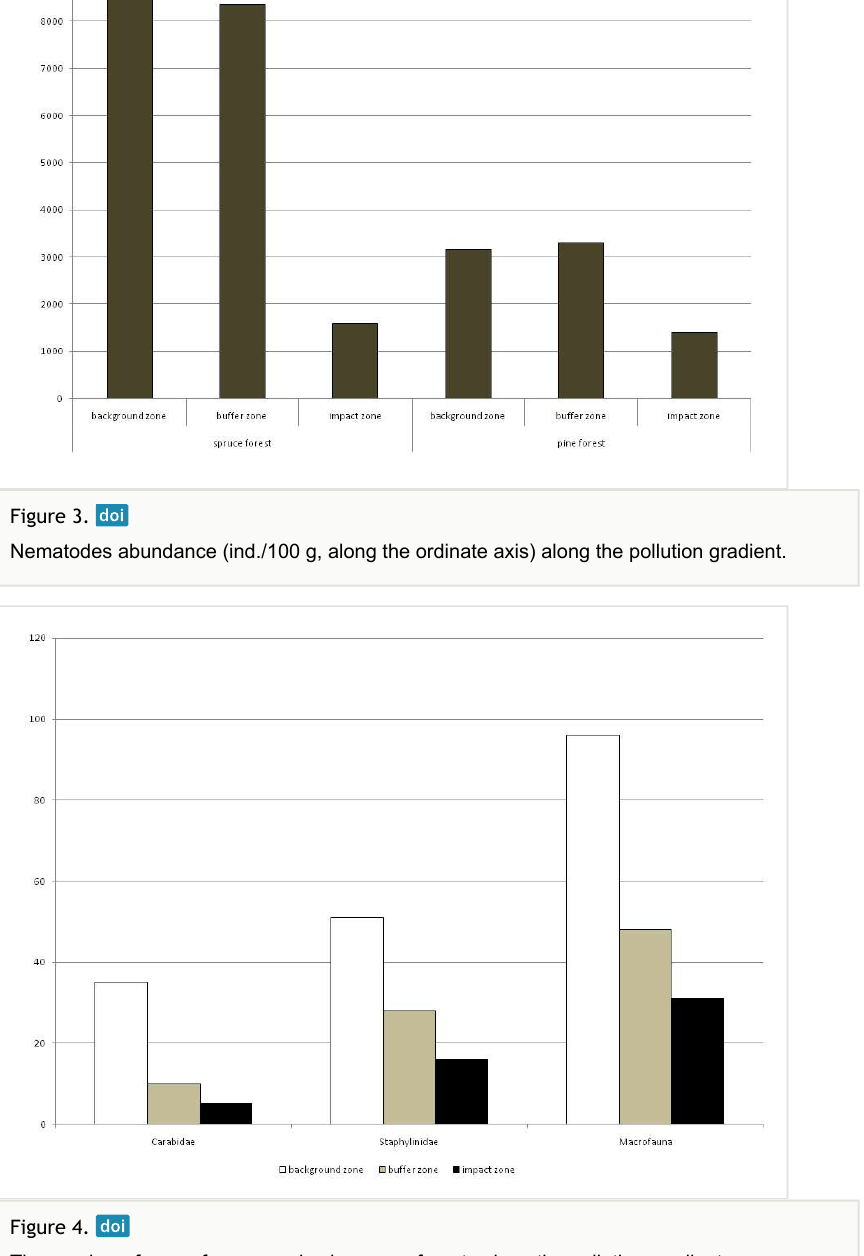
Figure 4. The number of macrofauna species in spruce forests along the pollution